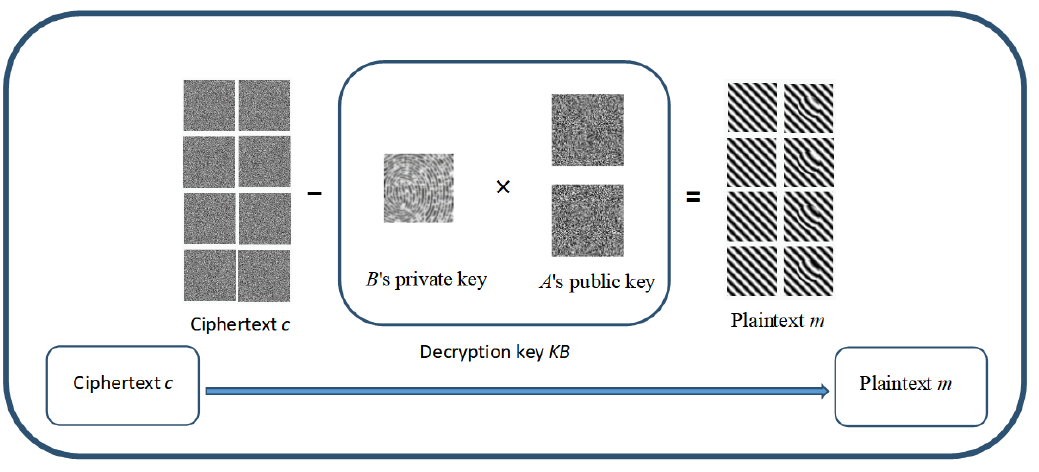
Figure 3. Elliptic curve decryption flow chart.